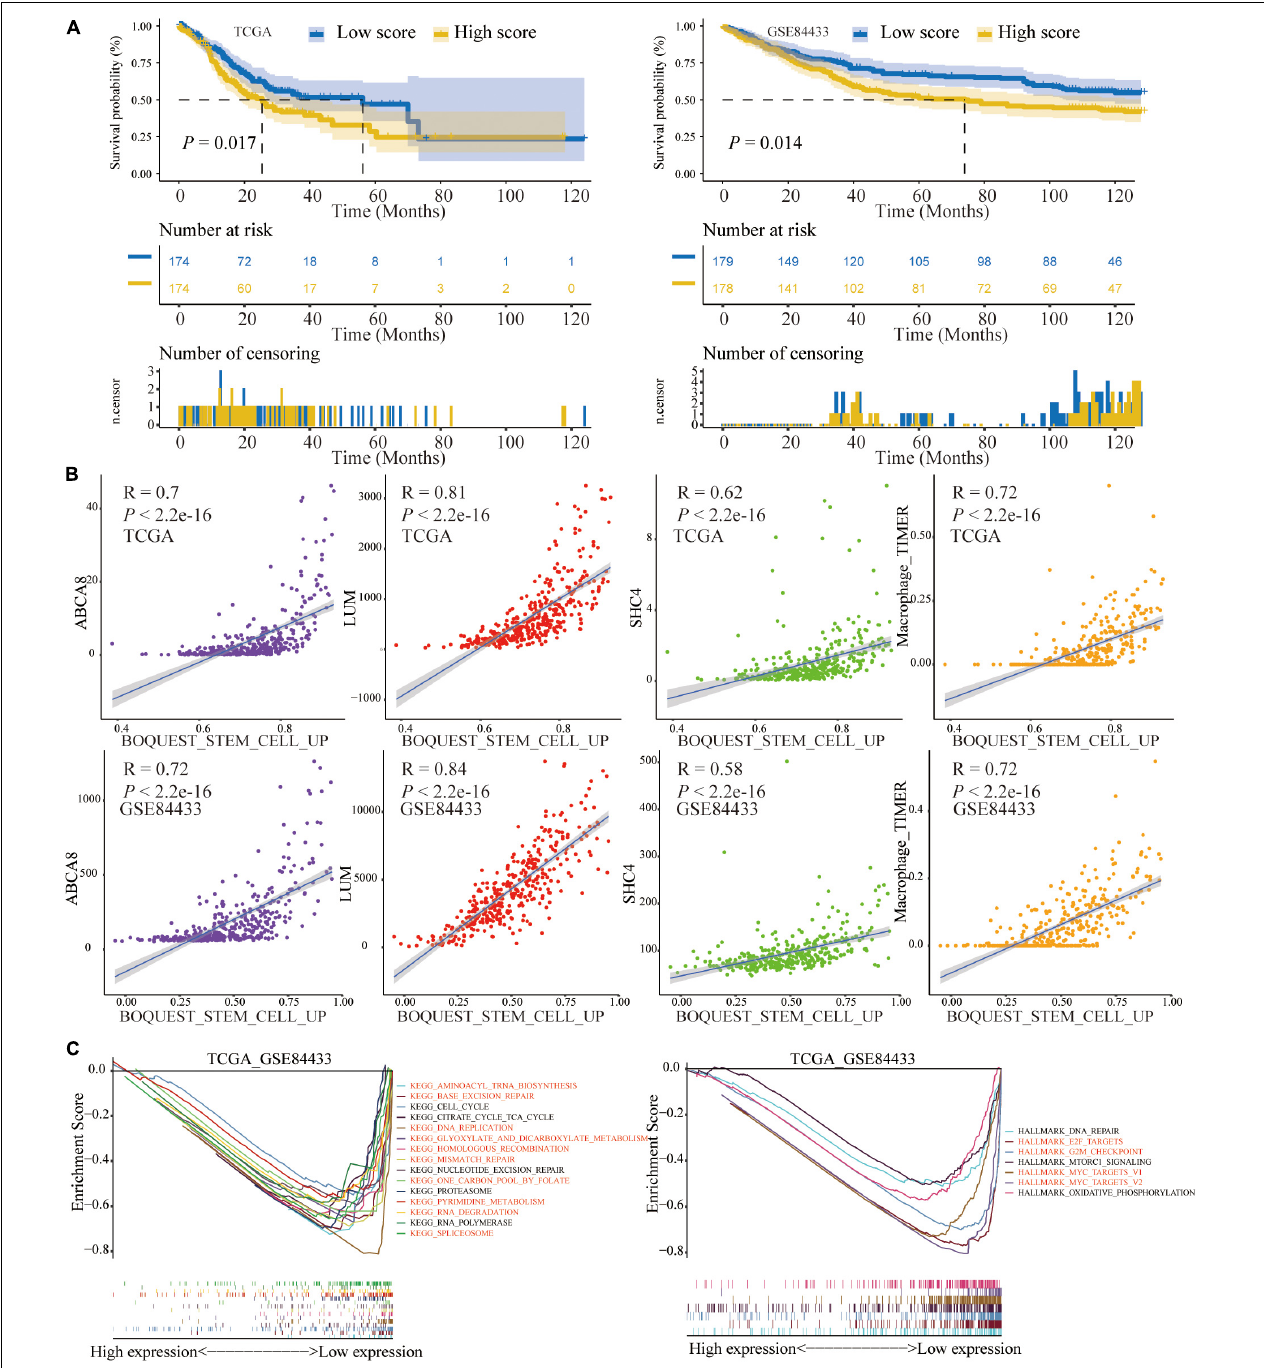
FIGURE 12 | The prognosis and correlation significance of BOQUEST_STEM_CELL_UP score. (A) The OS of low BOQUEST_STEM_CELL_UP group was significantly longer than that of high group. (B) Three key genes and macrophage abundance were significantly positively related with BOQUEST_STEM_CELL_UP score. (C) GSEA results between high and low BOQUEST_STEM_CELL_UP group, most of which were similar with that of 3 key genes and macrophage abundance and highlighted in